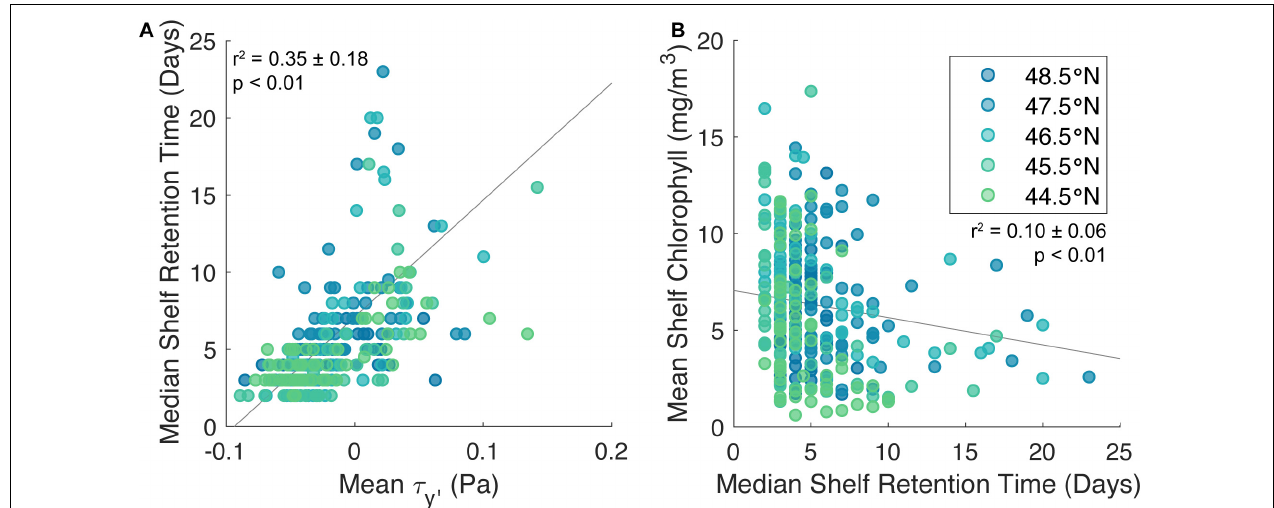
FIGURE 8 | Monthly median shelf retention time plotted against mean wind stress ( A ) and monthly mean shelf chlorophyll concentration plotted against median shelf retention time ( B ) for 2003–2009. Results from 44.5 ◦ N through 48.5 ◦ N are colored by latitude, with more northern latitudes in blues and more southern latitudes in greens. Trendlines for each relationship are plotted in gray [ r 2 = 0.35 ± 0.11, p < 0.01 ( A ); r 2 = 0.10 ± 0.06, p < 0.01 ( B )]. There are five instances of retention times > 25 days that are left off this figure in the interest of resolution of the low retention values. In this figure, retention times (T) are calculated from model output while wind stress and chlorophyll concentrations are calculated from the same satellite data used previously.